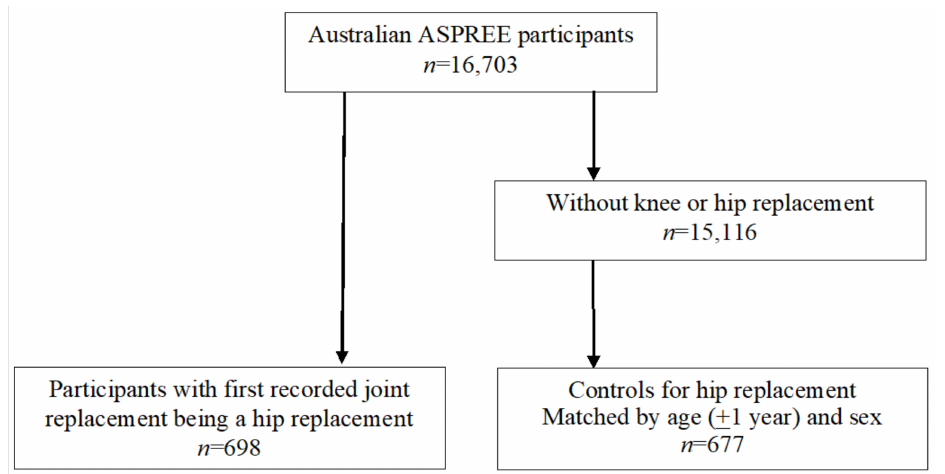
Figure 1. Participants with hip replacement and age- and sex-matched controls. ASPREE: ASPirin in Reducing Events in the